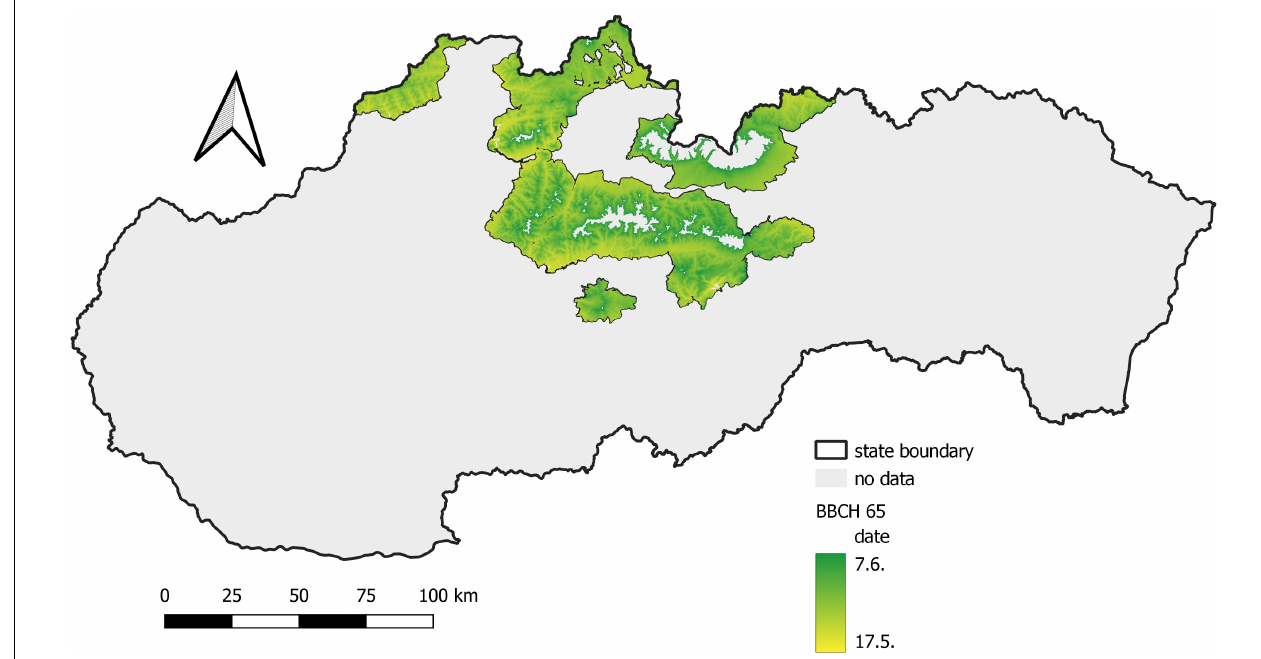
FIGURE 3 | Average onset of full flowering of Norway spruce in the period 1961–1990.